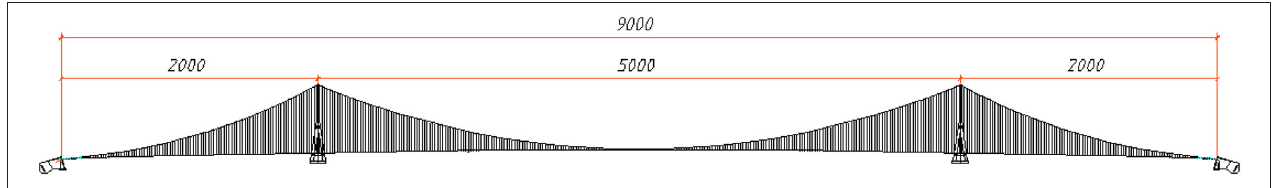
FIGURE 3 | Layout of the investigated bridge (unit: meter).